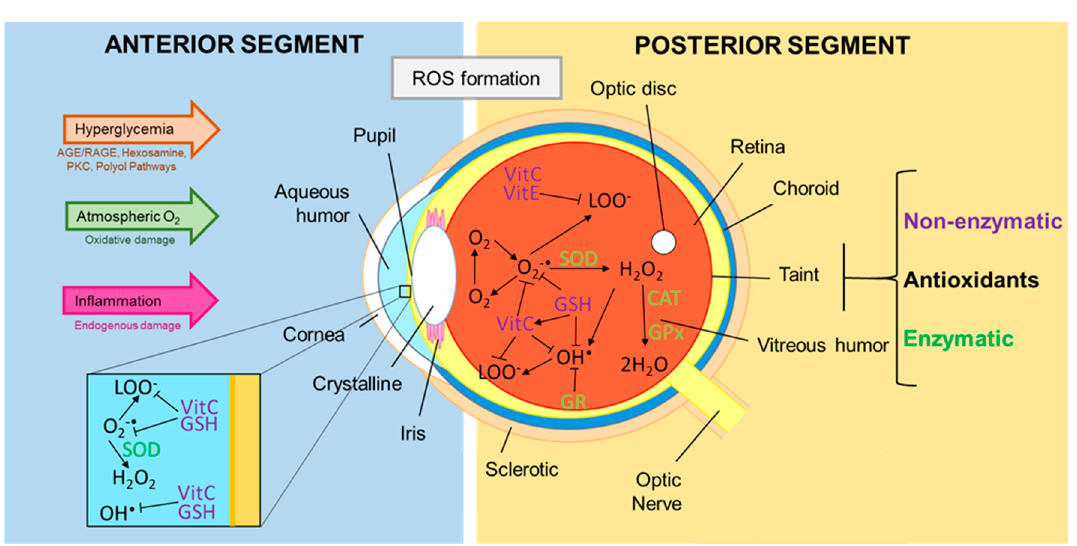
Figure 1. Reactive oxygen species and antioxidants in the eye. In the eye, chronic hyperglycemic state, atmospheric O2, and inflammation processes alter different metabolic pathways which stimulates the formation of reactive oxygen species (ROS) in the anterior and posterior segment, starting with oxygen (O2) to which the addition of one electron forms the superoxide anion radical (O2-•), the dismutation of this molecule by superoxide dismutases (SOD) forms hydrogen peroxide (H2O2), and the breakdown of this molecule can generate hydroxyl radical (OH•) which is highly reactive. In addition the reaction of O2- • or OH• radical with polyunsaturated fatty acids generates the peroxyl radical (LOO•). The formation of this radicals can be countered by enzymatic and non-enzymatic antioxidants like vitamin C, vitamin E, glutathione (GSH), glutathione peroxidase (GPx), superoxide dismutase (SOD), catalase (CAT), and glutathione reductase (GR), among others. (Modified from Chen Y, Mehta G, Vasiliou V. Antioxidant defenses in the ocular surface. Ocul Surf. 2009;7(4):176–185. doi:10.1016/s1542-0124(12)70185-4).